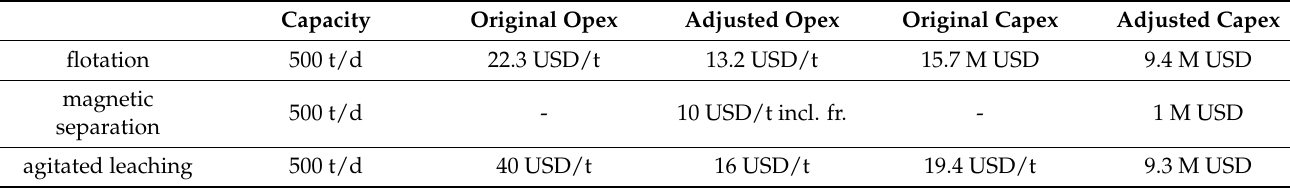
Table 8. Original (costmine©) and modified (adjusted to a tailings processing facility) opex in USD/t and capex in M USD for a 500 t/d flotation and magnetic separation processing plant. Costs for magnetic separation are inclusive of freight costs to the port of Caldera.